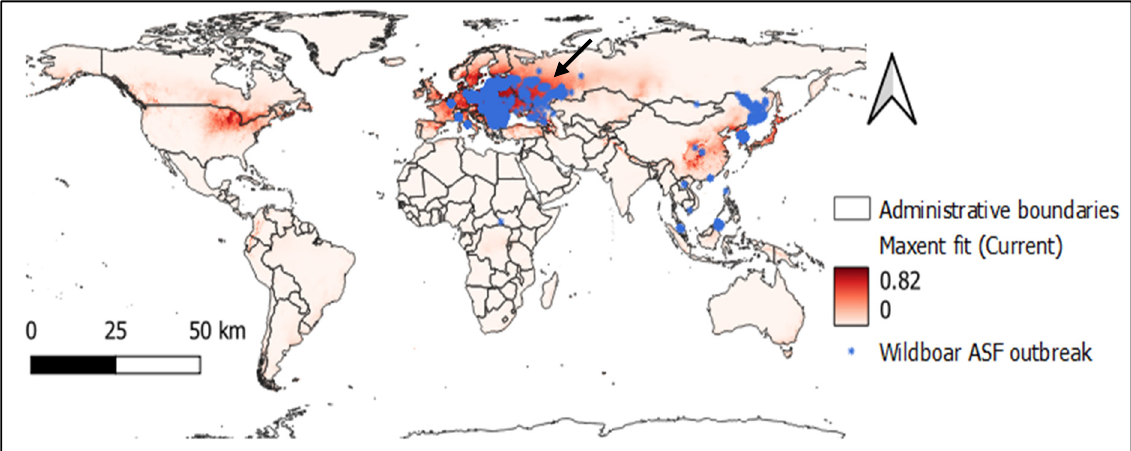
Figure 2. Maxent predicted map with current bioclimatic features and wild boar ASF outbreak locations (black arrow points to Europe as the recent hotspot of ASFV).